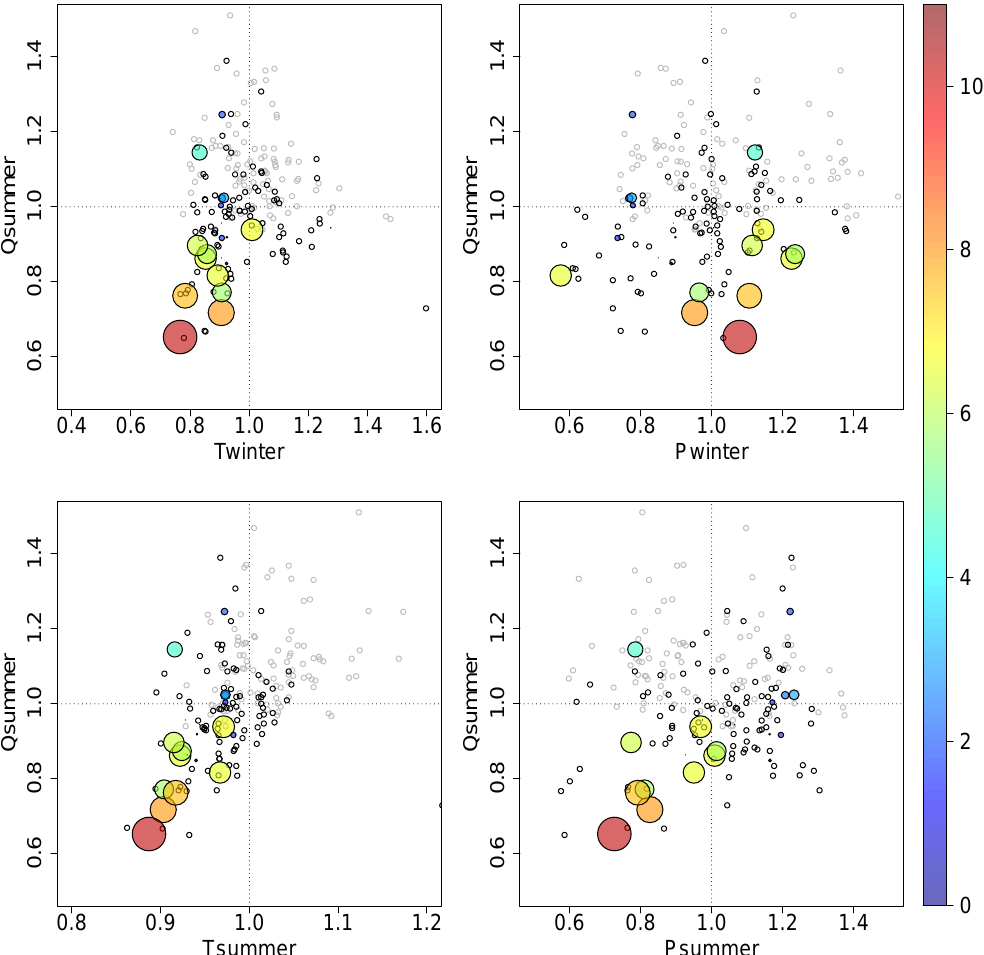
Figure 6. Glaciermelt drought events in Austrian catchments: standardised summer discharge ( Q summer ) (–) against standardised causing factors ( T winter , P winter , T summer , P summer ) (–). Below 1 = below average; above 1 = above average. Grey circles: all years; black circles: all drought years; coloured circles: glaciermelt drought years (size and colour of dots are dependent on standardised drought deficit (–); scale on the right side of the figure).